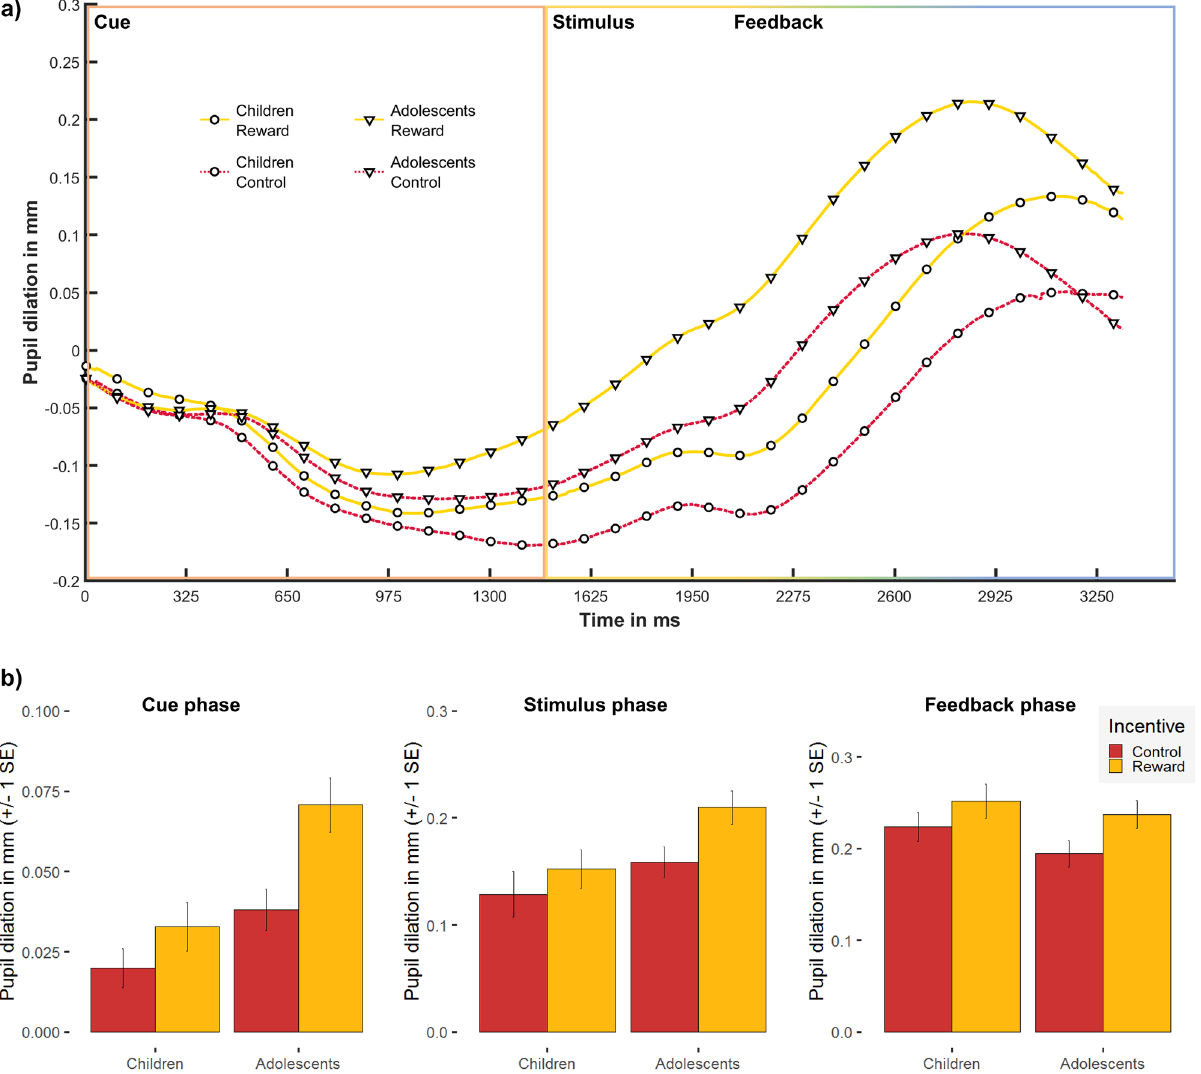
Figure 4. Pupillometry measures: ( a ) Mean pupil response (pupil dilation in millimetre) across the time course of the trial (in milliseconds) and the associated phase, stimulus-locked to the onset of the cue (zero point in time) and separated for the two incentive conditions (reward vs. control) and age groups (children vs. adolescents); ( b ) mean and standard error (SE) for the pupil dilation (in millimetres) measured at the peak of the pupil response during reward anticipation (cue phase; left), numerosity discrimination (stimulus phase; middle), and processing of the outcome (feedback phase; right), separated for the two incentive conditions (reward vs. control) and age groups (children vs.